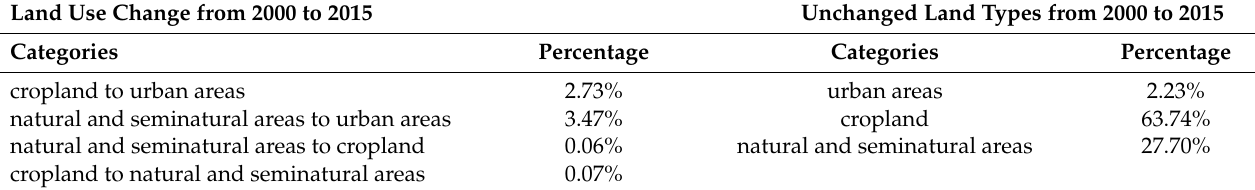
Table 2. Statistics on the proportion of land type change.